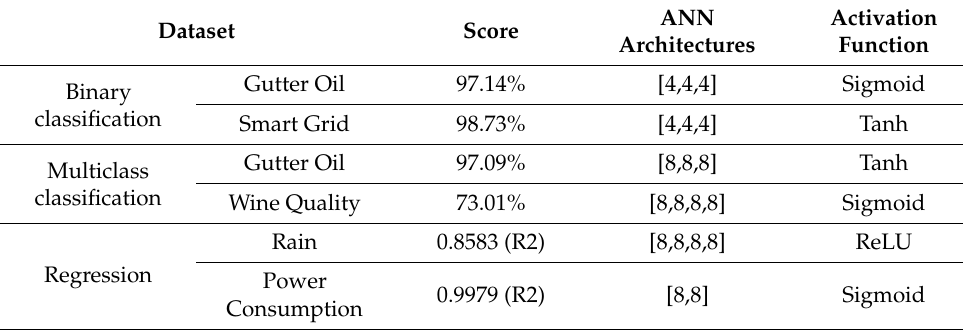
Table 7. The highest-scoring parameters of ANN obtained in different